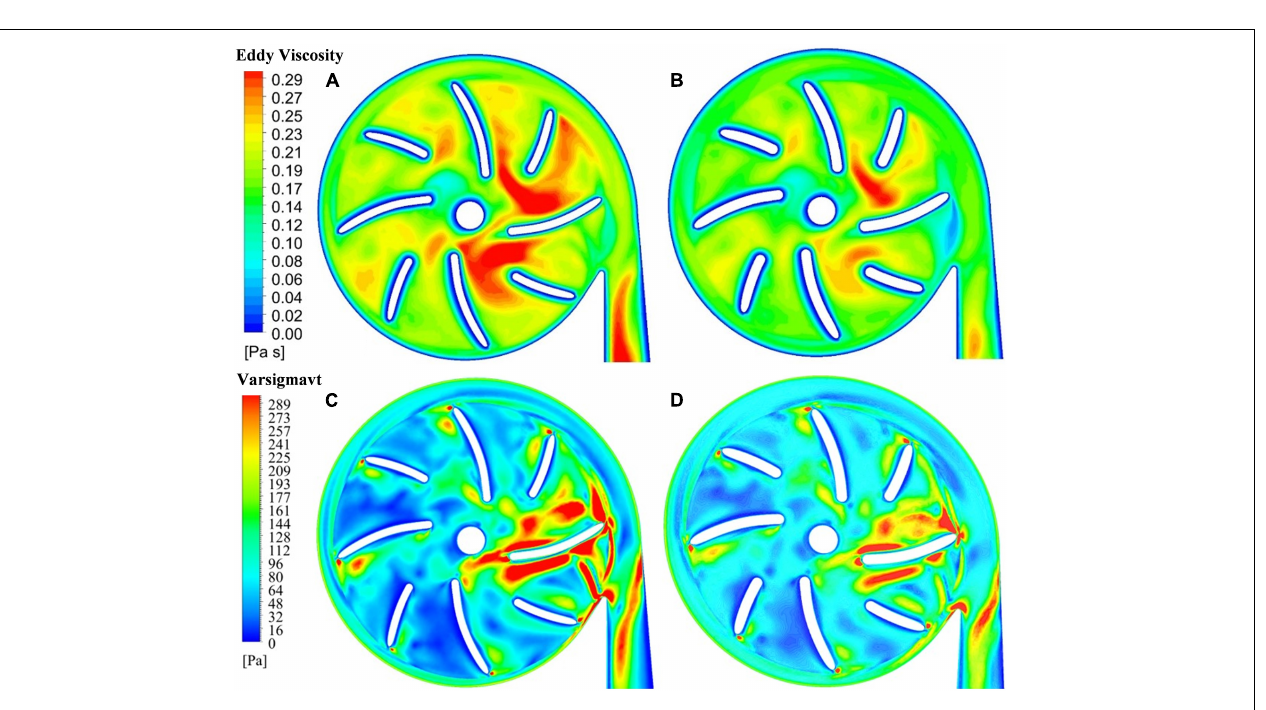
Frontiers in Physiology |